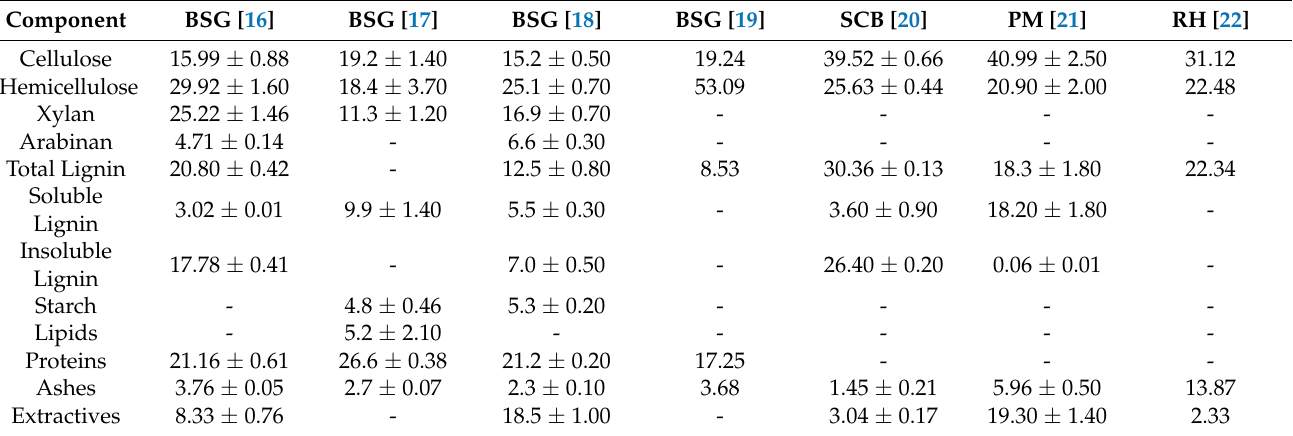
Table 2. Chemical composition of different brewer’s spent grain (BSG) samples and comparison